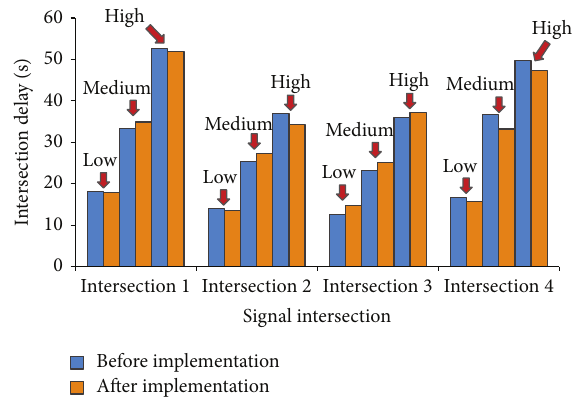
Figure 4: Average vehicular delay at intersections under different level of